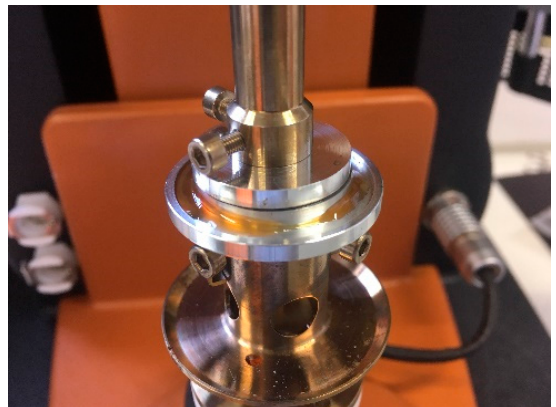
Figure 7. Shear rheology sample preparation showing the excess material and 0.6 mm gap.